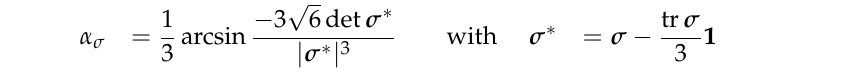
0.005. ( a ) The initial void ratio is normally ± ±